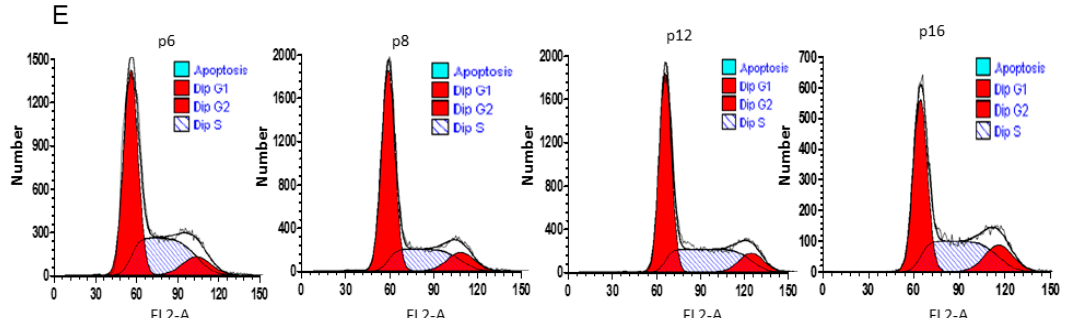
Figure 3. Ad-MSCs express pluripotency markers and are viable over several passages. ( A ) Vimentin